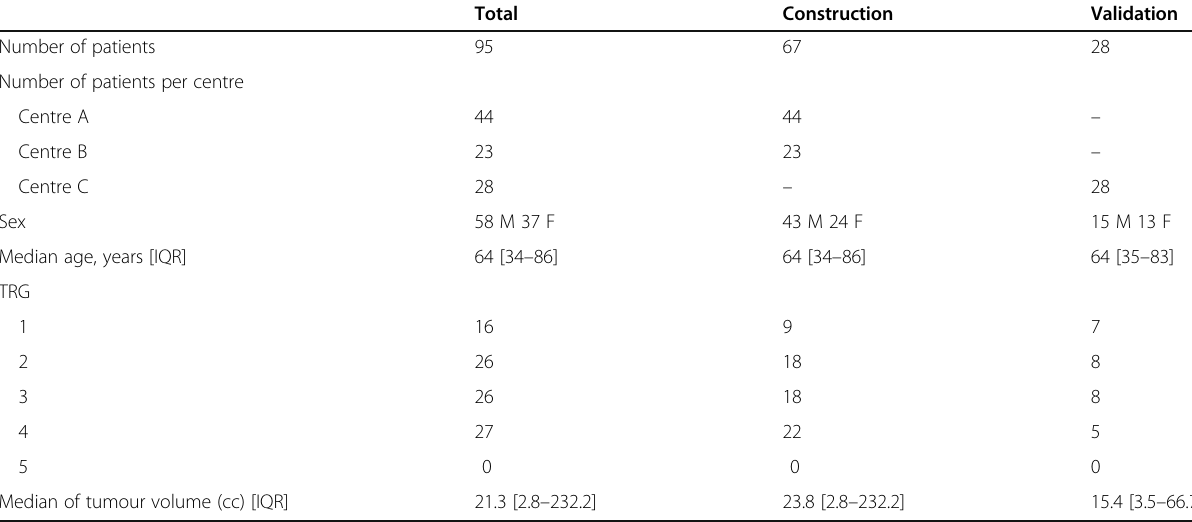
Table 2 Patient and tumour